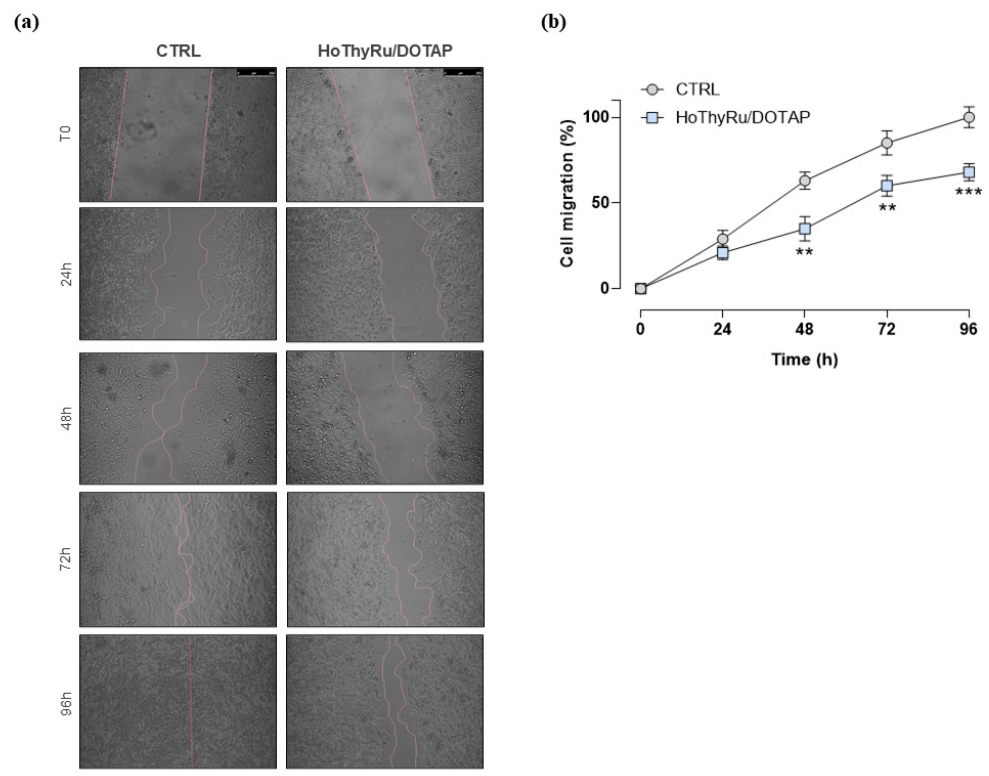
Figure 7. Wound healing assay showed inhibitory effects of HoThyRu/DOTAP on cell migration. ( a ) Representative images by light microscopy showing MDA-MB-231 cell migration for the indicated times (0, 24, 48, 72, and 96 h), previously treated or not for 48 h with HoThyRu/DOTAP at the sub-IC 50 concentration of 24 µ M. The scale bar represents 250 µ M. ( b ) At the endpoints, migration was monitored under a phase contrast microscope (10 × objective), and the percentage of wound closure depending on cell migration ability was determined by ImageJ FIJI software and reported in a line graph as the average ± SEM values of three independent experiments. ** p < 0.01 vs. control cells; *** p < 0.001 vs. control cells.